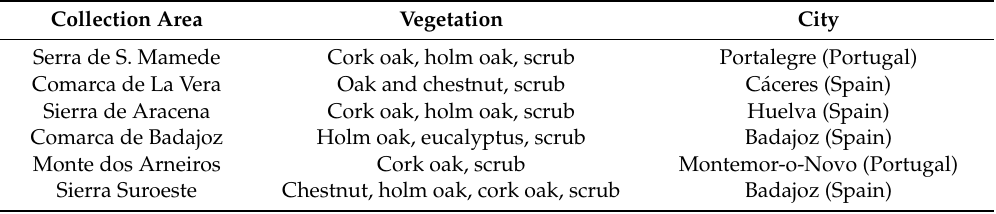
Table 2. Most significant vegetation type and collection areas.